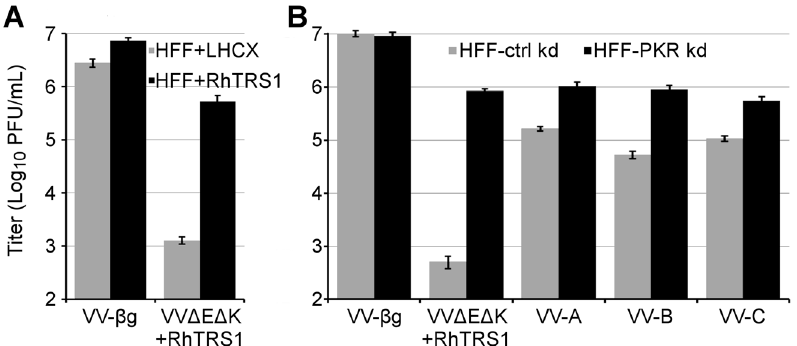
Figure 5. RhTRS1 overexpression or PKR knockdown permits efficient VV D E D K + RhTRS1 replication in HFF. (A) Viral production 48 hpi of control (HFF + LHCX, grey bars) or HFF expressing RhTRS1 (HFF + RhTRS1, black bars) with the indicated viruses (MOI=0.1), determined by titering on HFF + TRS1. (B) Viral production 48 hpi of control (HFF-ctrl kd) or HFF with PKR knocked down by shRNA (HFF-PKR kd) with the indicated viruses (MOI=0.1), determined by titering on BSC40 cells. Data are represented as mean + 1